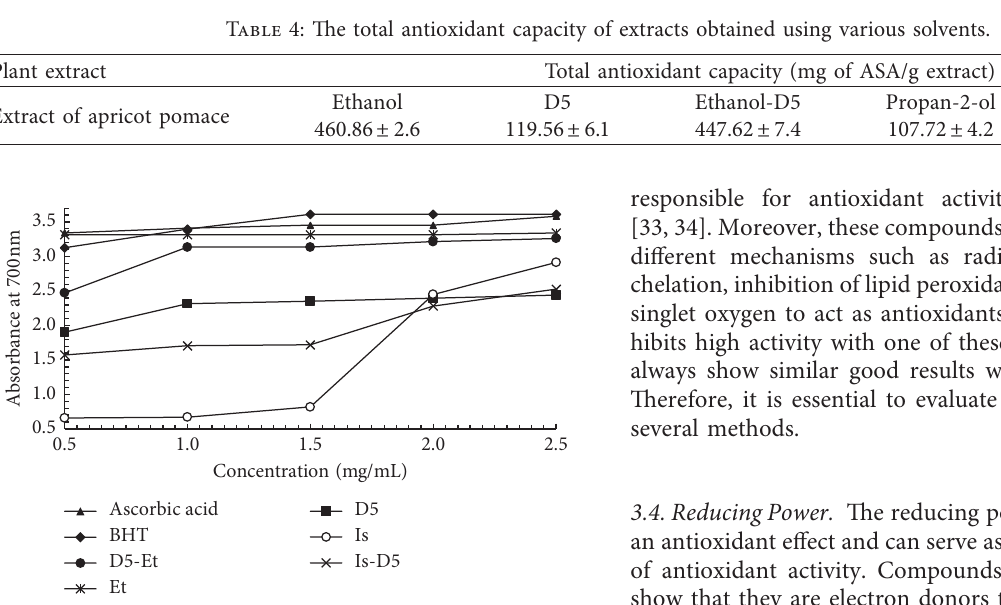
Figure 4: Reducing power of extracts obtained by various